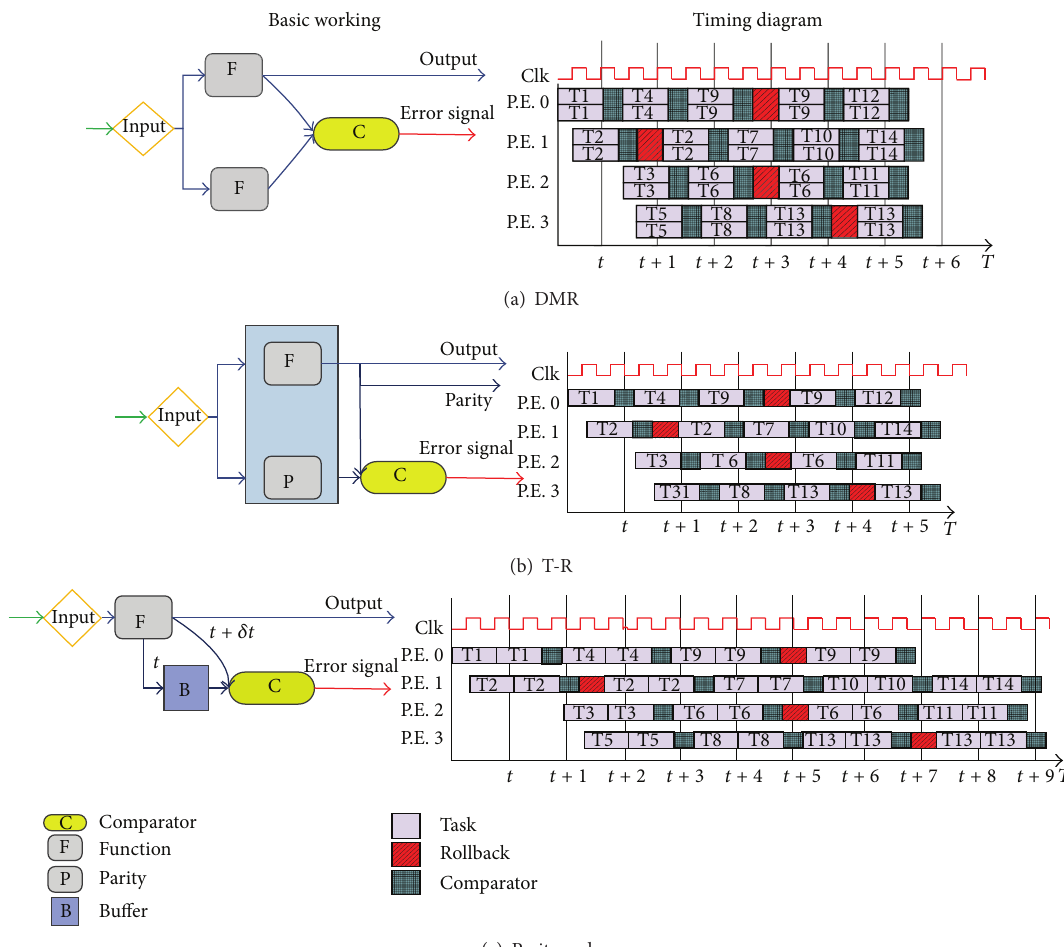
Figure 1: Basic working and timing diagram of (a) DMR, (b) TR, and (c)